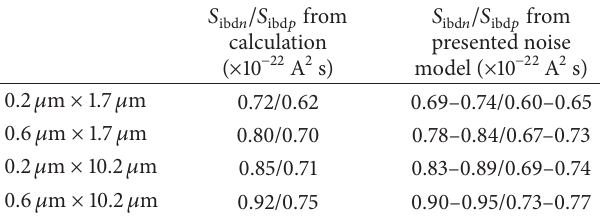
Table 2: Comparison between extracted and calculated breakdown noise spectral density at 𝑉 BE = 1.1 V and 𝑉 CE = 3.6 V for different sized SiGe HBTs.